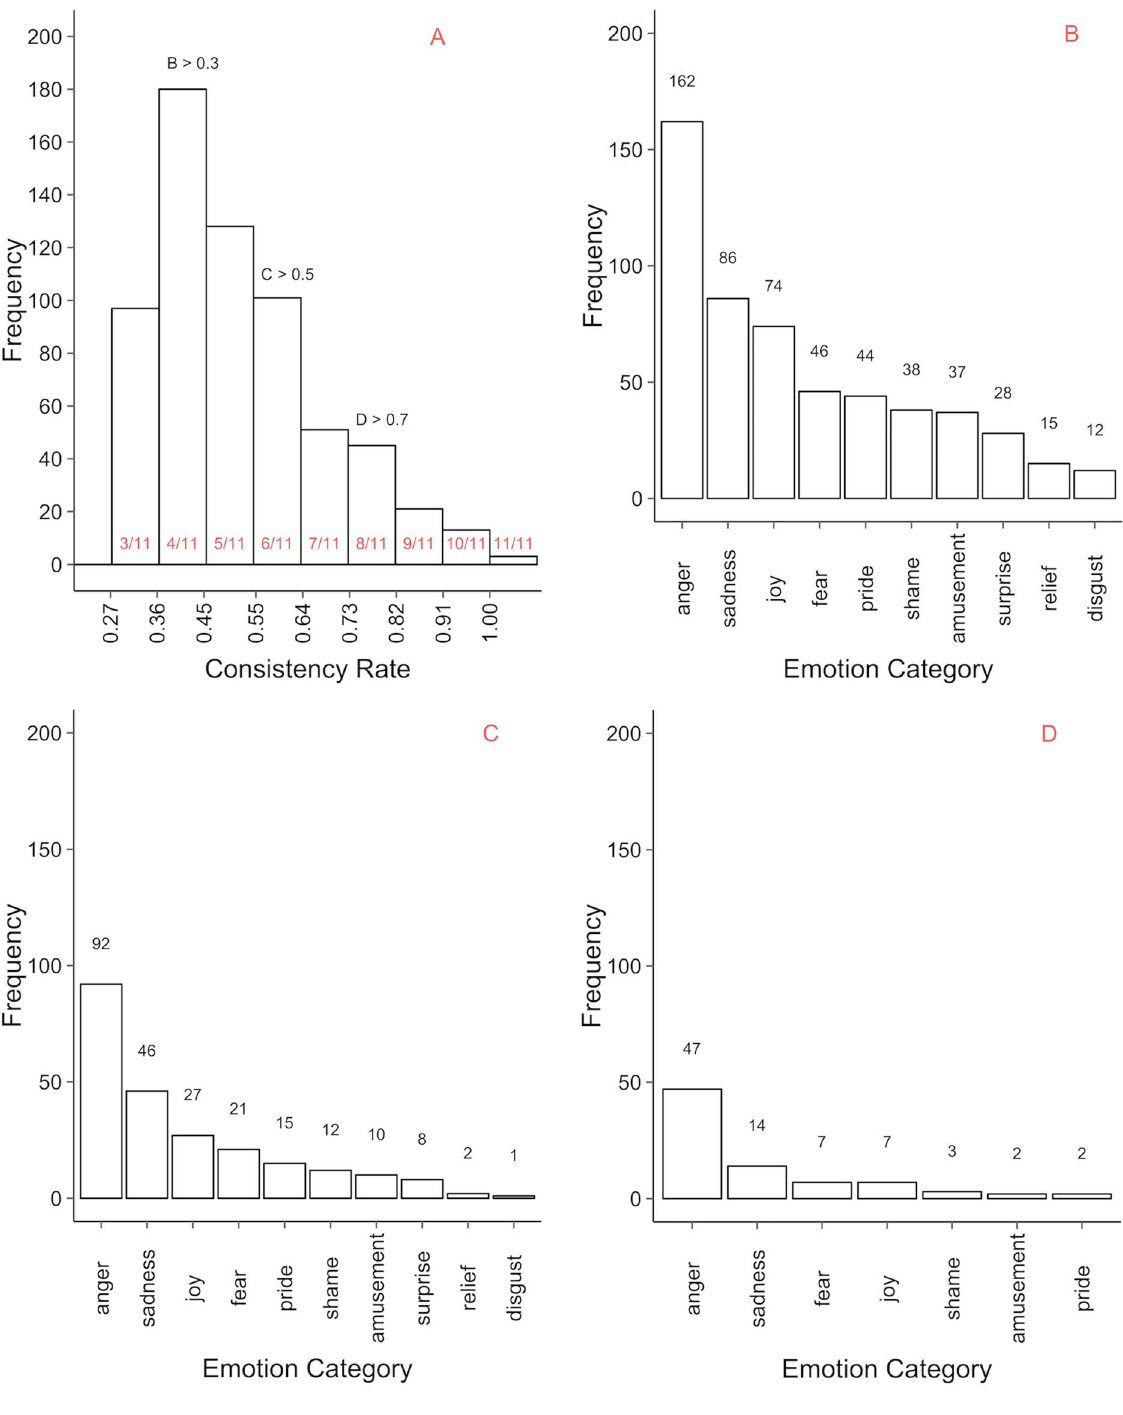
Figure 4. Emotion frequency distribution across consistency levels. (A) Histogram of consistency rates across motion sequences. The minimally possible consistency is always equal to one divided by the number of observations for the given stimulus and multiplied by two because there have to be at least two observers assigning the same category to the stimuli to form a modal value. (B) Distribution of perceived emotions across categories with a consistency rate of 0.3 or more. (C) Distribution of perceived emotions across categories with a consistency rate of 0.5 or more. (D) Distribution of perceived emotions across categories with a consistency rate of 0.7 or